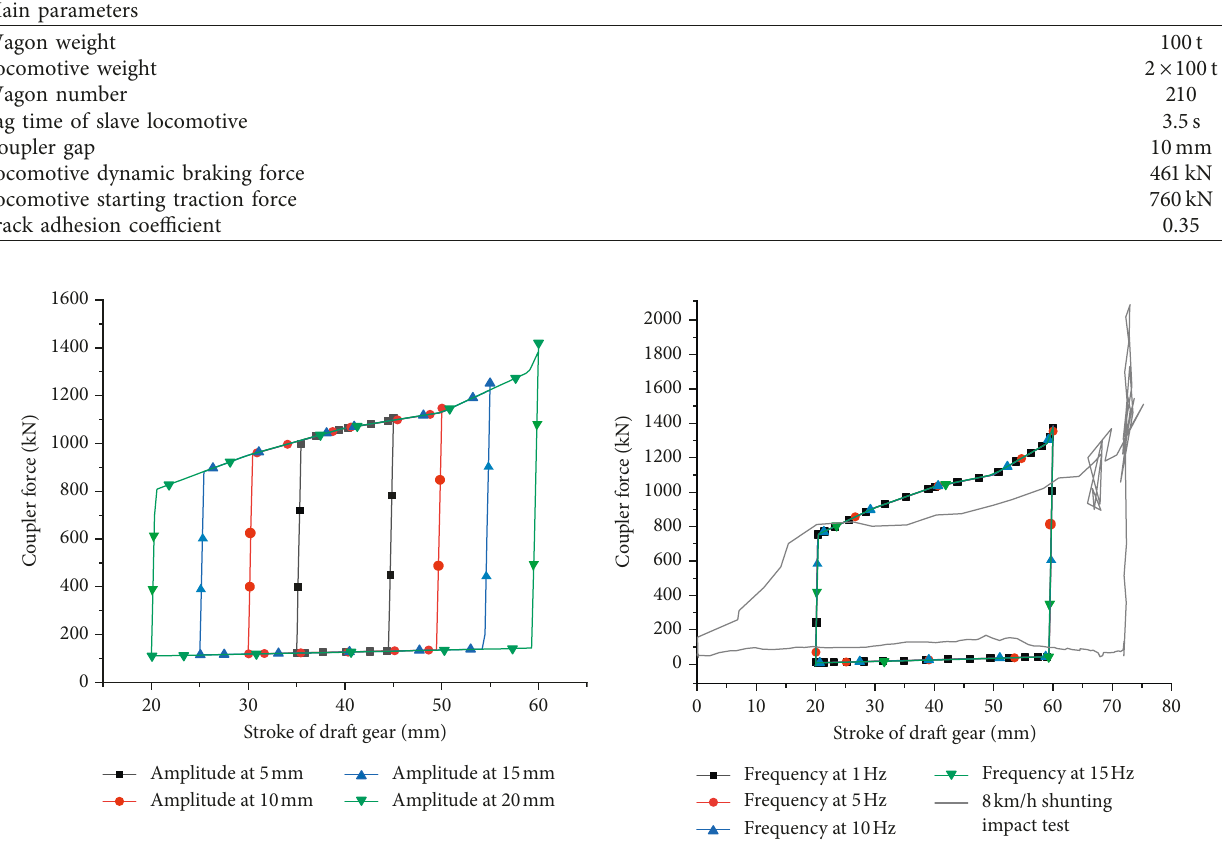
Table 2: Main parameters of the